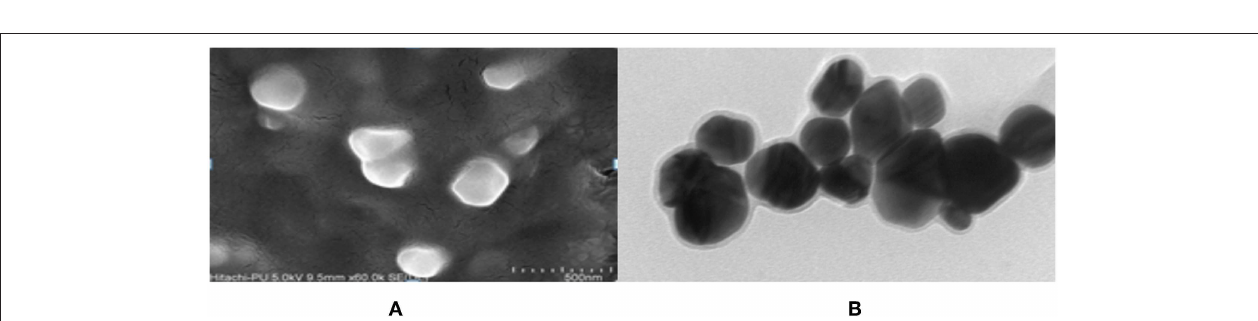
FIGURE 2 | Images showing (A) size and (B) zeta potential of AgNPs when seen through dynamic light scattering (DLS). NPs (22.4nm) were prepared in ethanol so as to control their size.